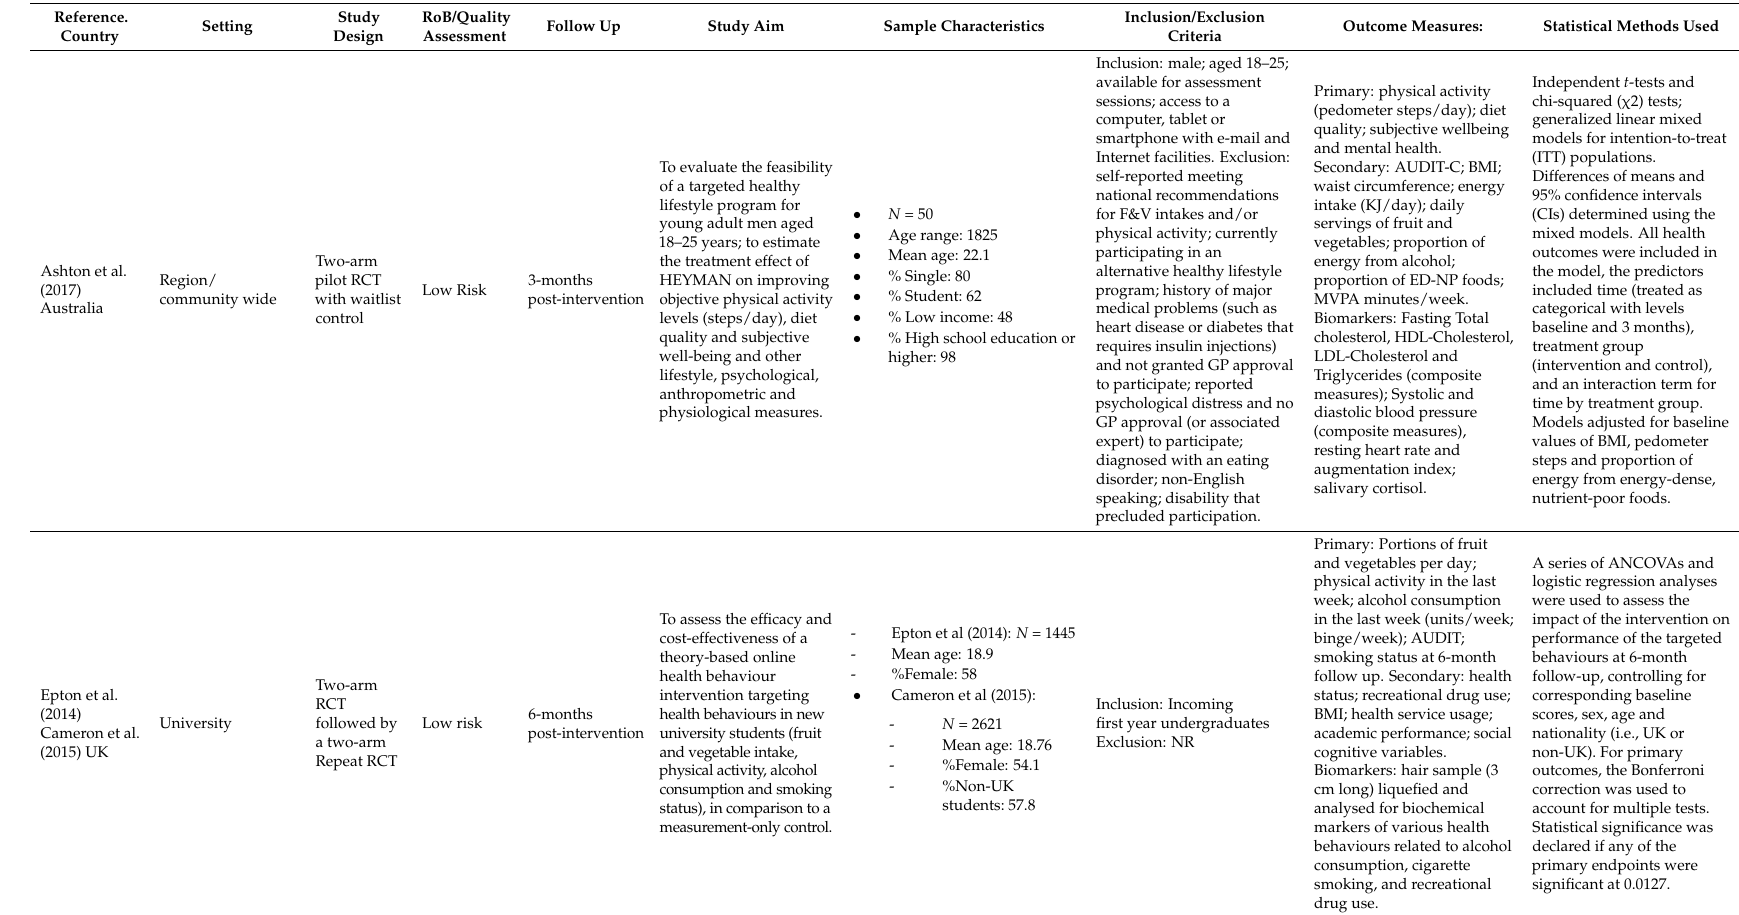
Table 1. Characteristics of included